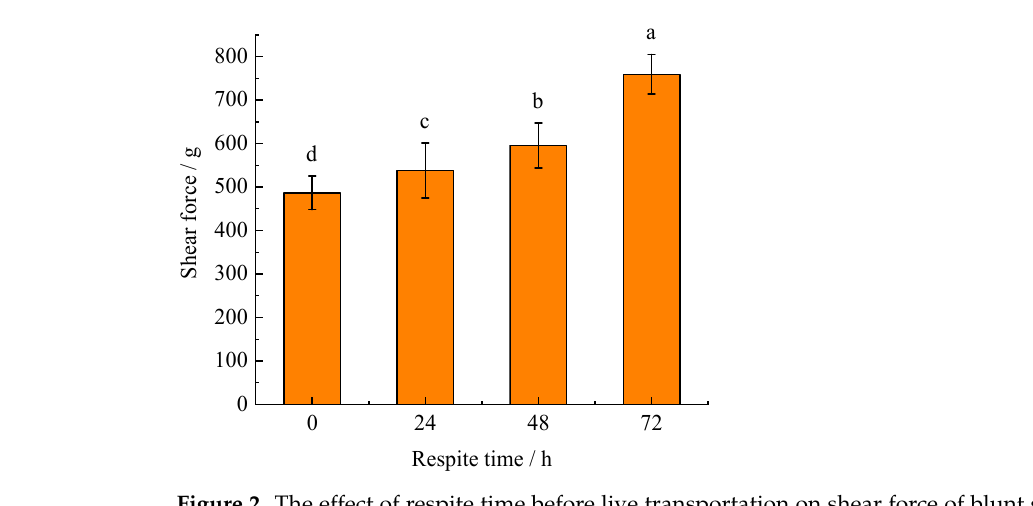
Table 3. The effect of respite time before live transportation on ATP-related compounds of blunt snout bream (n = 3 for each respite